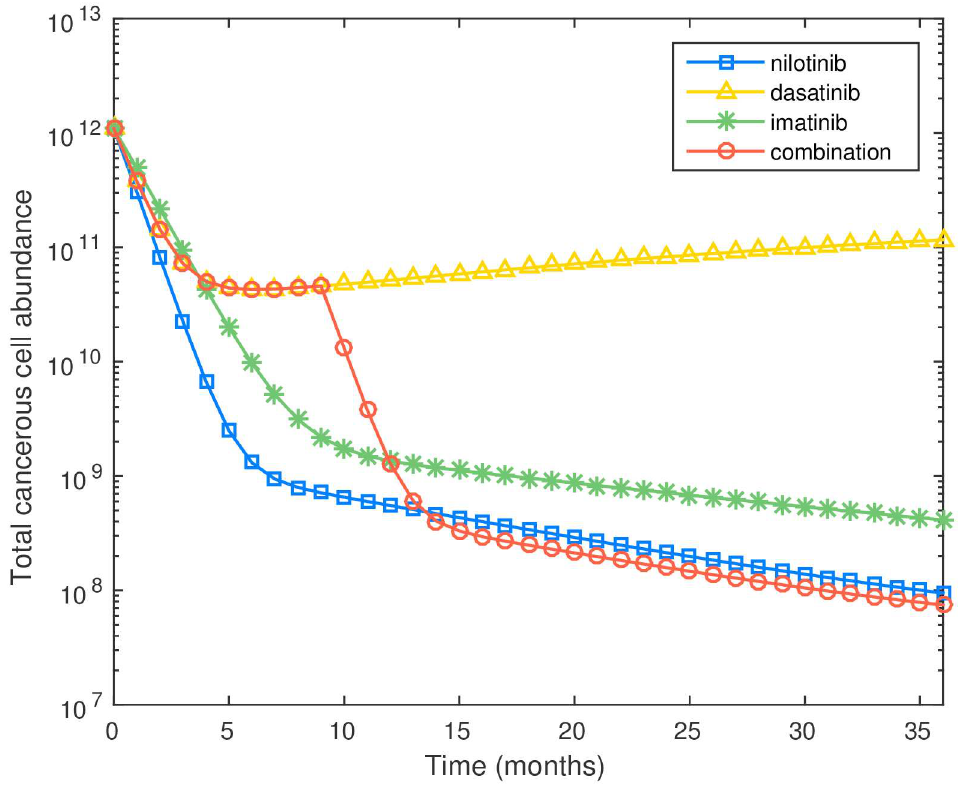
Fig 5. Plot of cell number versus time for three monotherapies and optimal combination therapy for preexisting F317L.